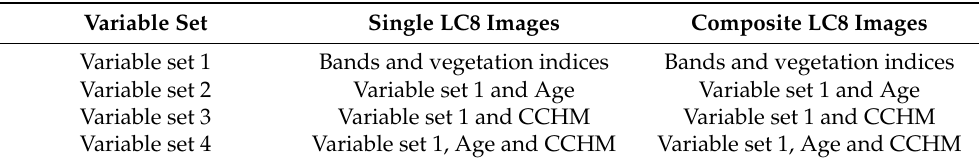
Table 1. The groups of variable